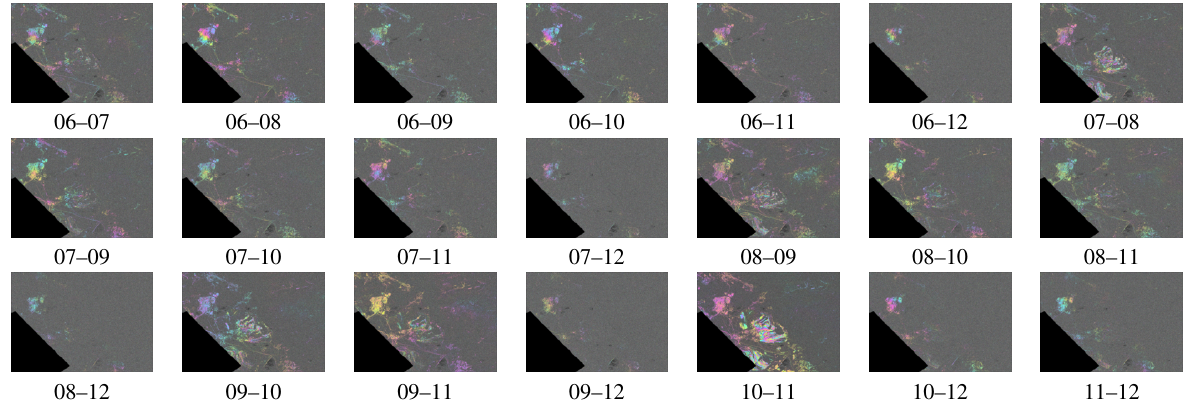
Figure 1: All processed interferograms. 06 stays for the scene acquired on June 17, 2011, 07 for the scene acquired on July 20, 2011, 08 for the scene acquired on August 22, 2011, 09 for the scene acquired on September 24, 2011, 10 for the scene acquired on October 27, 2011, 11 for the scene acquired on November 29, 2011, and 12 for the scene acquired on December 21, 2011. B T [days] B ⊥ [m]